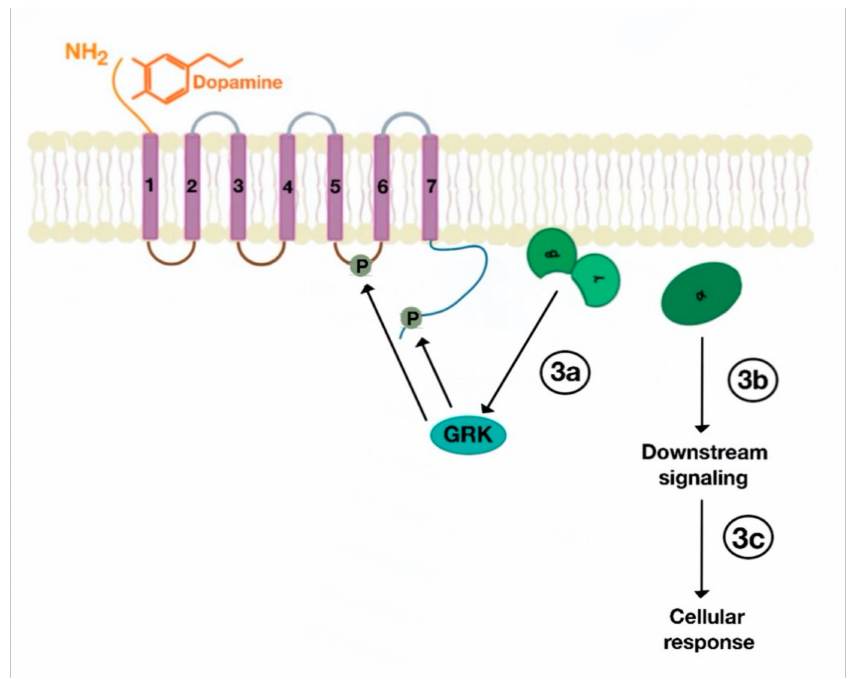
Figure 4. Uncoupling of G α subunit from G βγ subunit, followed by activation GPCR kinases (GRKs), which phosphorylate amino acids in the third intracellular loop of the transmembrane segments and C-terminal tail (3a). The uncoupled G α subunit activates downstream cellular (3b) and subsequent cellular response